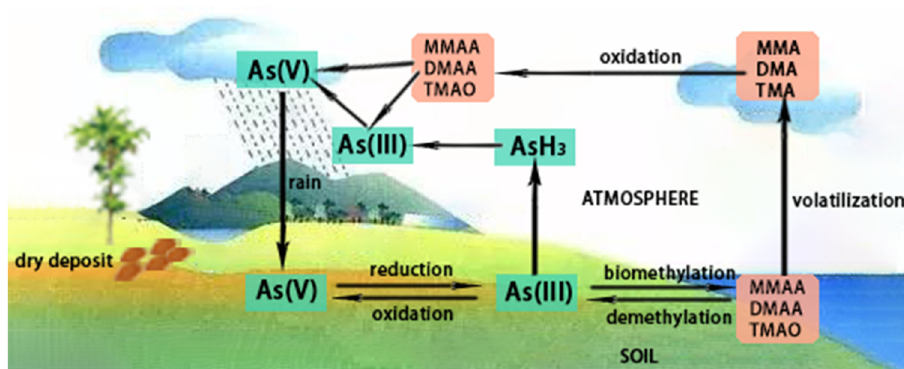
Figure 1: Biochemical transformation of As in nature. Microbial transformations ( → ) . MMAA: monomethylarsonic acid; DMAA: dimethyl - arsinic acid; TMAO: trimethylarsineoxide; MMA: monomethylarsine; DMA: dimethylarsine; TMA: